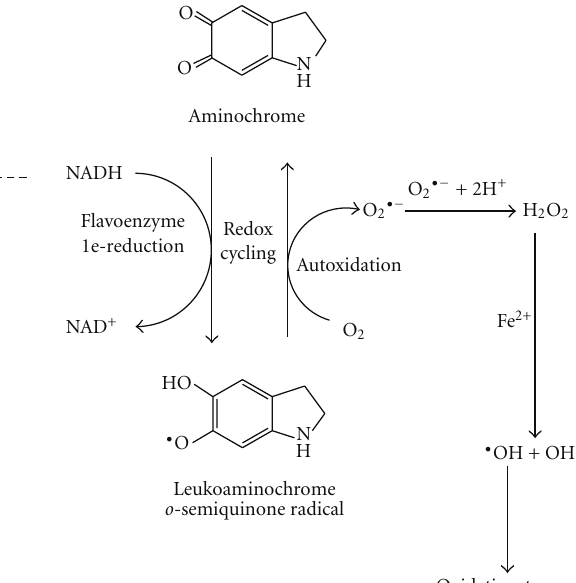
Figure 6: One-electron reduction of aminochrome. The one-electron reduction of aminochrome is catalyzed by flavoenzymes that utilize NADH as an electron donor, generating leukoaminochrome o -semiquinone radical. This radical is extremely reactive with oxygen and autoxidizes by reducing molecular oxygen to superoxide radicals. This redox cycling induces oxidative stress and depletes the NADH required for the generation of energy (ATP) in the mitochondria. Redox cycling can also be catalyzed by flavoenzymes that utilize NADPH as an electron donor, depleting the NADPH required for the reduction of oxidized glutathione.